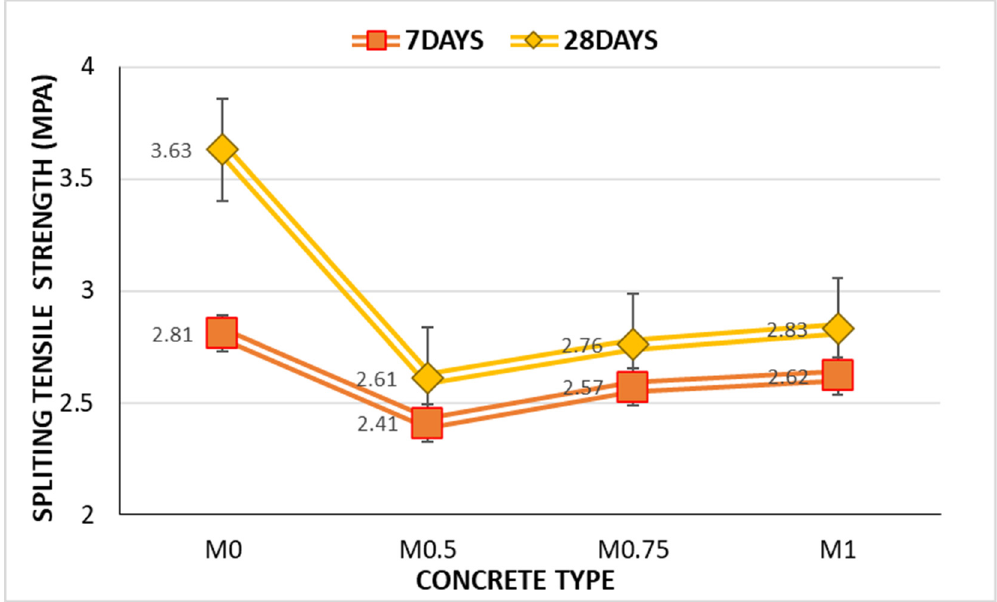
Figure 13. Splitting tensile strength value of different types of SCC mixes.